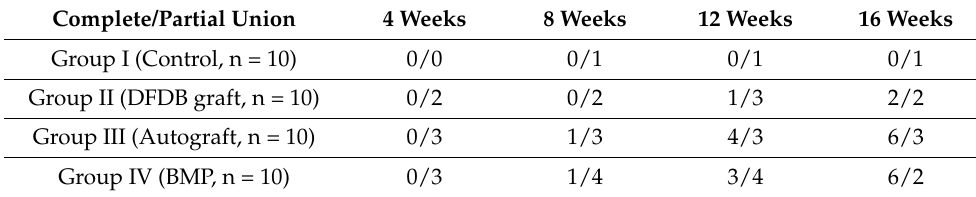
Table 1. Radiologic union. Radiologic union was assessed by bony bridge formation of the cortex. A complete union was defined as the bony bridge formation of both cortexes in radiography. A partial union was defined as the bony bridge formation of one cortex. The numbers stated in the table (number/number) represent complete union/partial union. (one-way ANOVA, p < 0.05. Posthoc test with Scheffe, group I vs. group II, p = 0.231; group I vs. group III, p < 0.001, group I vs. group IV, p < 0.001; group II vs. group III, p = 0.035; group II vs. group IV, p = 0.044, group III vs. group IV, p = 0.766).